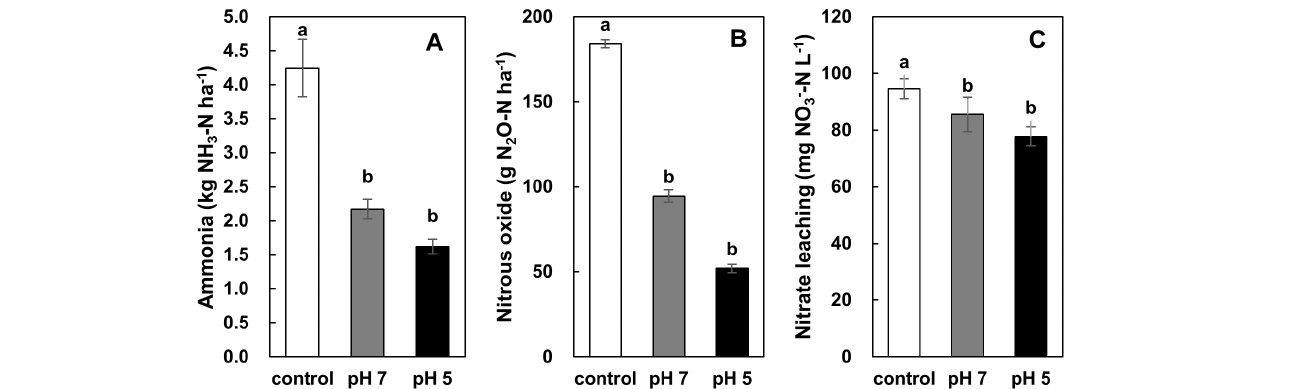
Figure 2. Total emission of ammonia (A) and nitrous oxide (B) and nitrate leaching (C), as estimated by cumulative amount for 56 days of regrowth. The values are mean±standard deviation of four replicates. Different letters in horizontal row indicate significantly different at p<0.05 according to the Duncan’s multiple range